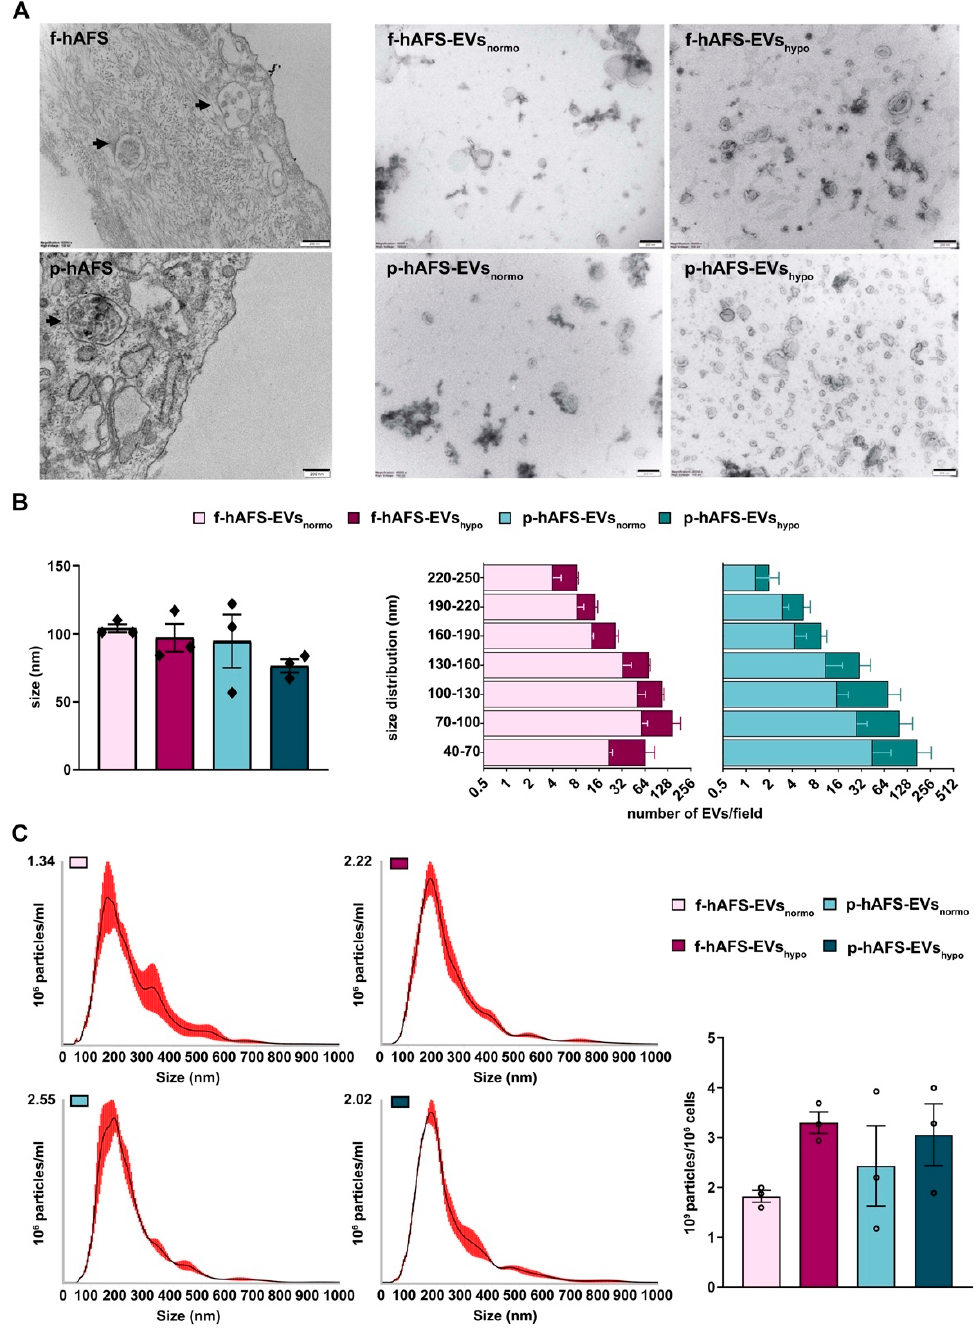
Figure 4. Morphological characterization of fetal- and perinatal hAFS-EVs. ( A ) Representative images of transmission electron microscopy (TEM) of: f-hAFS and p-hAFS (upper and lower left panel, respectively, black arrows indicating intracytoplasmic multi-vesicular bodies with small EVs/exosomes within them), and of f-hAFS-EVs and p-hAFS-EVs (upper and lower right panel, respectively) released in serum-free conditions and under normoxic versus hypoxic preconditioning (f-hAFS-EVs normo ; f-hAFS-EVs hypo ; p-hAFS-EVs normo ; and p-hAFS-EVs hypo , respectively), scale bars: 200 nm. ( B ) Left panel: TEM analysis of hAFS-EVs size distribution; right panel: distribution of the number f-hAFS-EVs and p-hAFS-EVs per field size intervals from 40 nm up to 250 nm were considered; values are expressed as mean ± s.e.m of n = 3 independent experiments. ( C ) Nanoparticle tracking analysis for hAFS-EVs size and distribution. Left panel: representative image of the graphical output; right panel: hAFS-EVs concentration measured as 10 9 particles per 10 6 secreting cells; nm: nanometer; ml: milliliter .